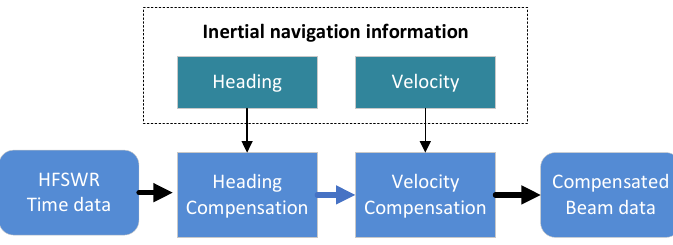
Figure 11. Flow chart of motion compensation for shipborne HFSWR.